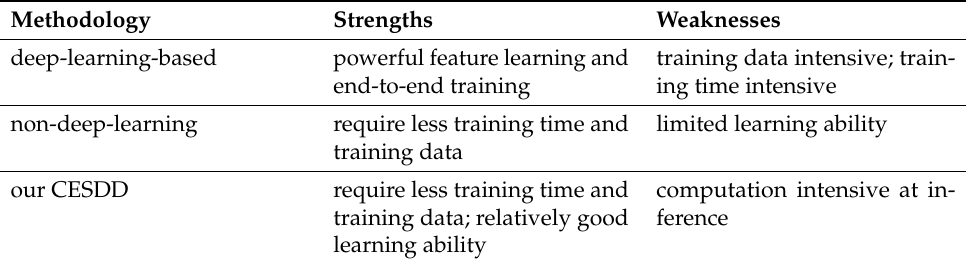
Table 1. Comparison of deep-learning-based, non-deep-learning vehicle detection approaches and our CESDD